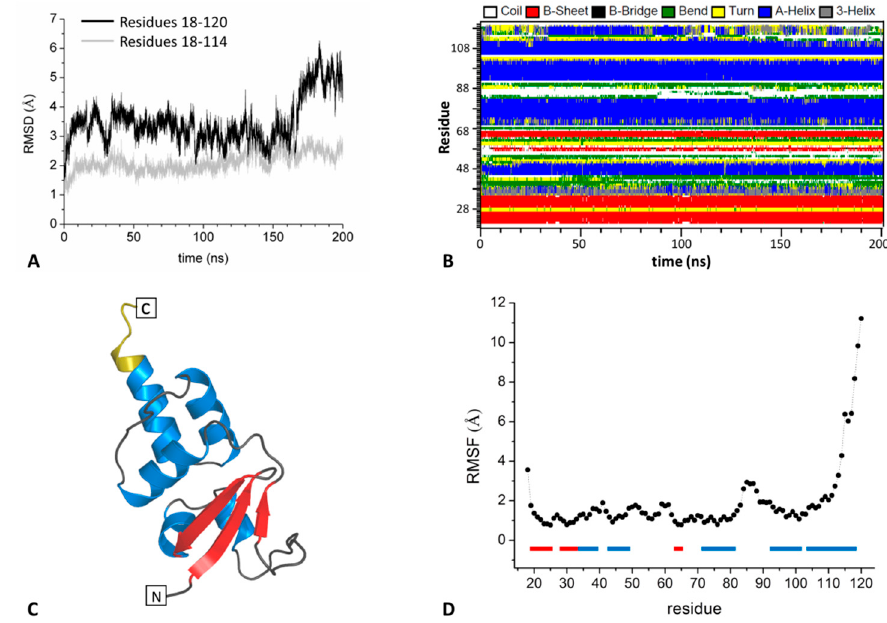
Figure 2. Structure stability of SHKBP1 BTB throughout the simulation: C α -based RMSD values of trajectory structures calculated against the starting crystallographic model ( A ), time evolution of the secondary structure content ( B ). The RMSD values have been calculated on the whole structure (residues 18-120, black) or by excluding the last six residues at the C-terminus (residues 18-114, grey). Cartoon representation of SHKBP1 BTB ( C ), α -helices and β -strands are colored in blue and red, respectively. The last six residues at the C-terminus are in yellow. C α -based RMSF values of residues of SHKBP1 BTB calculated in the 50–200 ns trajectory region ( D ) . The protein secondary structure elements are reported as bars ( α -helices in blue and β -strands in red).